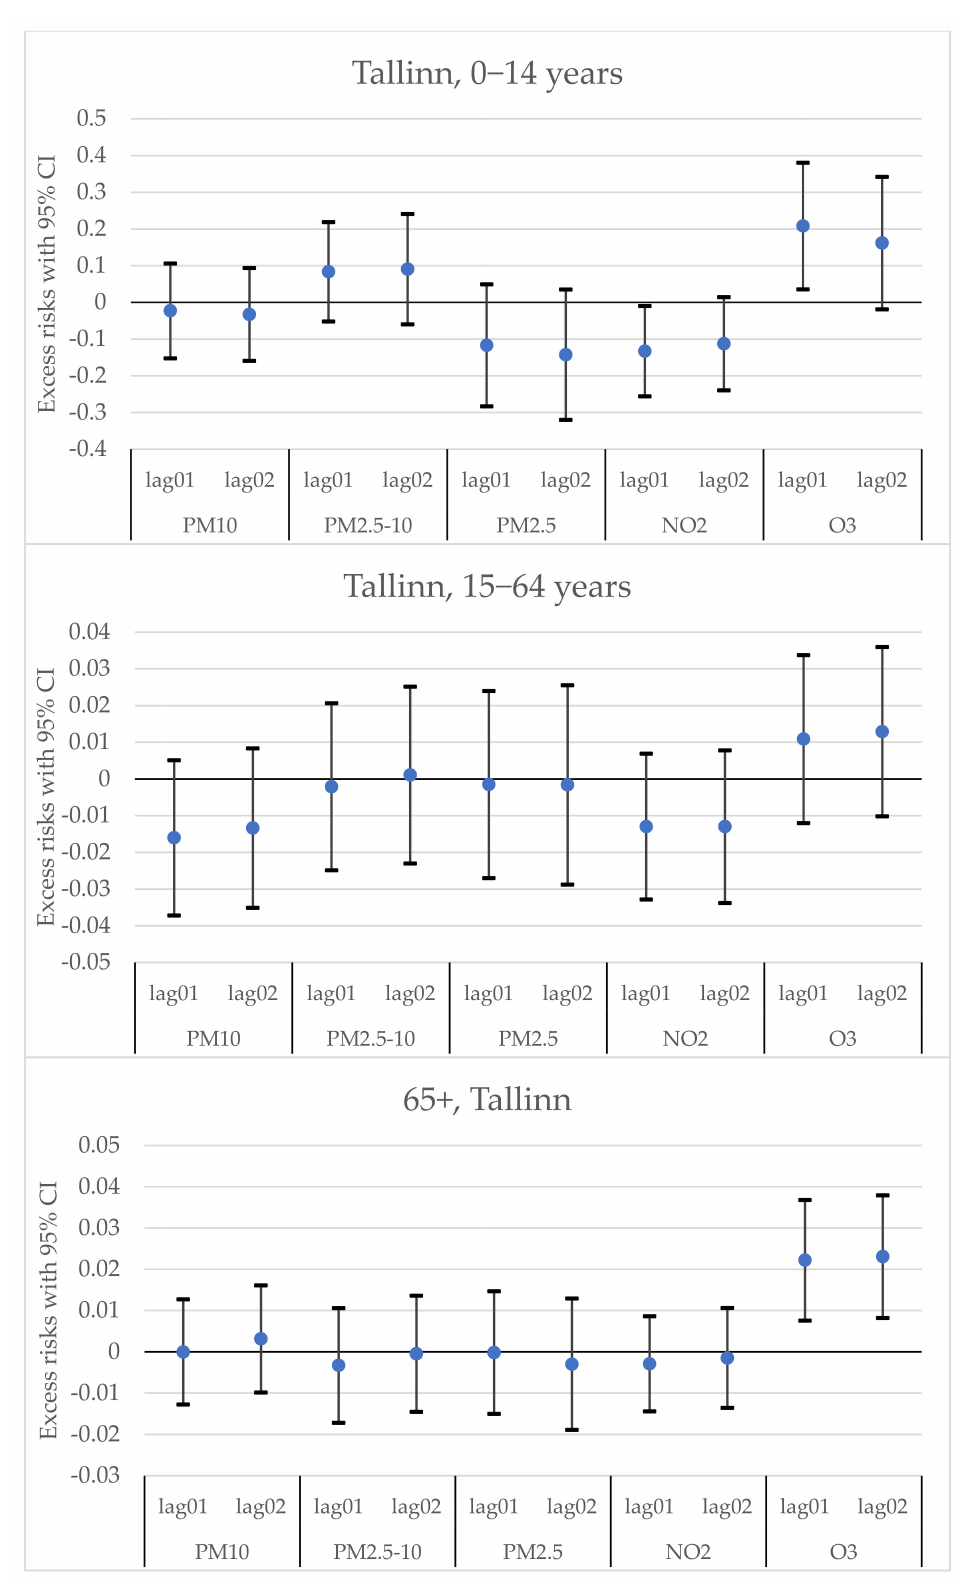
Figure 2. Single-pollutant models of the estimated change in daily mortality in different age groups (with 95% CI) for an IQR increase in the concentrations (lag01 and lag02) of different air pollutants in